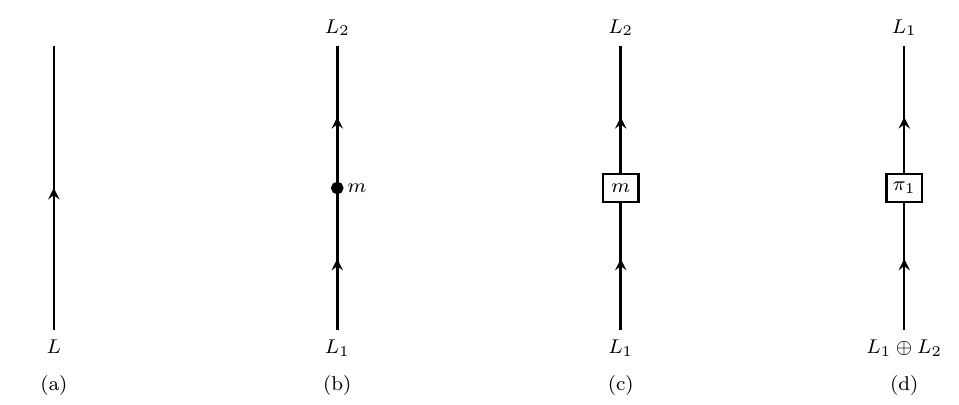
Figure 6 . Data of a category C : (a) A line defect (shown here with its orientation) is an object in C . (b) A local operator between two lines is a morphism in C . (c) Another representation of the previous (cid:12)gure (common in mathematics literature) in which morphisms are denoted by boxes. (d) The direct sum L 1 (cid:8) L 2 of two line defects can be projected to an individual summand by a local operator.